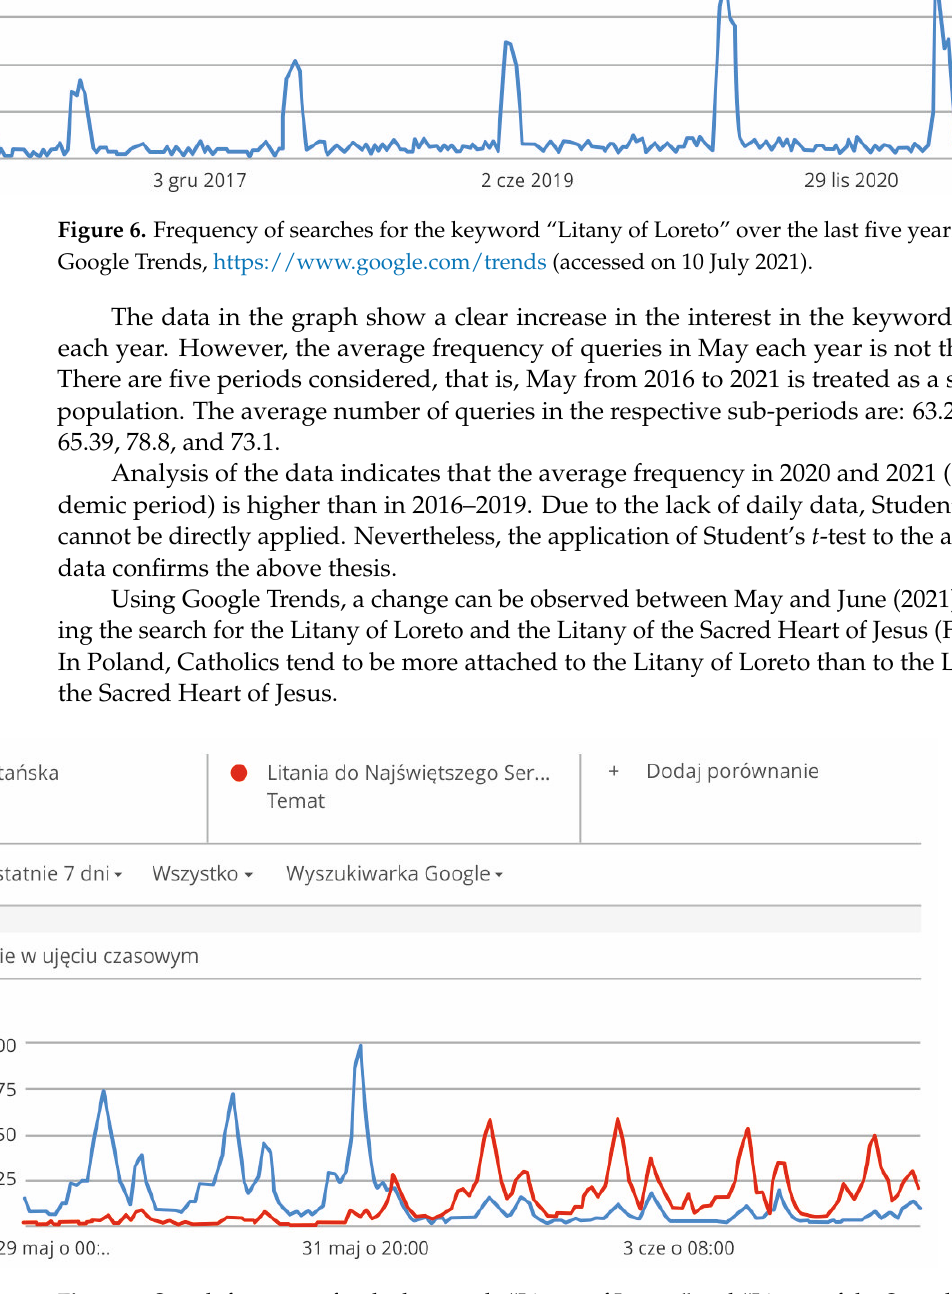
Figure 8. Frequency of searches for the keyword “prayer” over the last five years; source: Google Trends, https://www.google.com/trends (accessed on 23 August 2021). As far as the regional analysis is concerned, the Podkarpackie voivodeship has the highest level of searches in the analysed period and is, therefore, the reference for all the other regions. The Lubelskie (92%) and Podlaskie (84%) voivodeships showed a high level of interest in the keyword “prayer” compared to Podkarpackie. In the Ma ł opolskie and Ś wi ę tokrzyskie voivodeships, the search percentage was around 80%. The search rates in Dolno ś l ą skie (49%) and Zachodniopomorskie (45%) were at the opposite end of the scale.